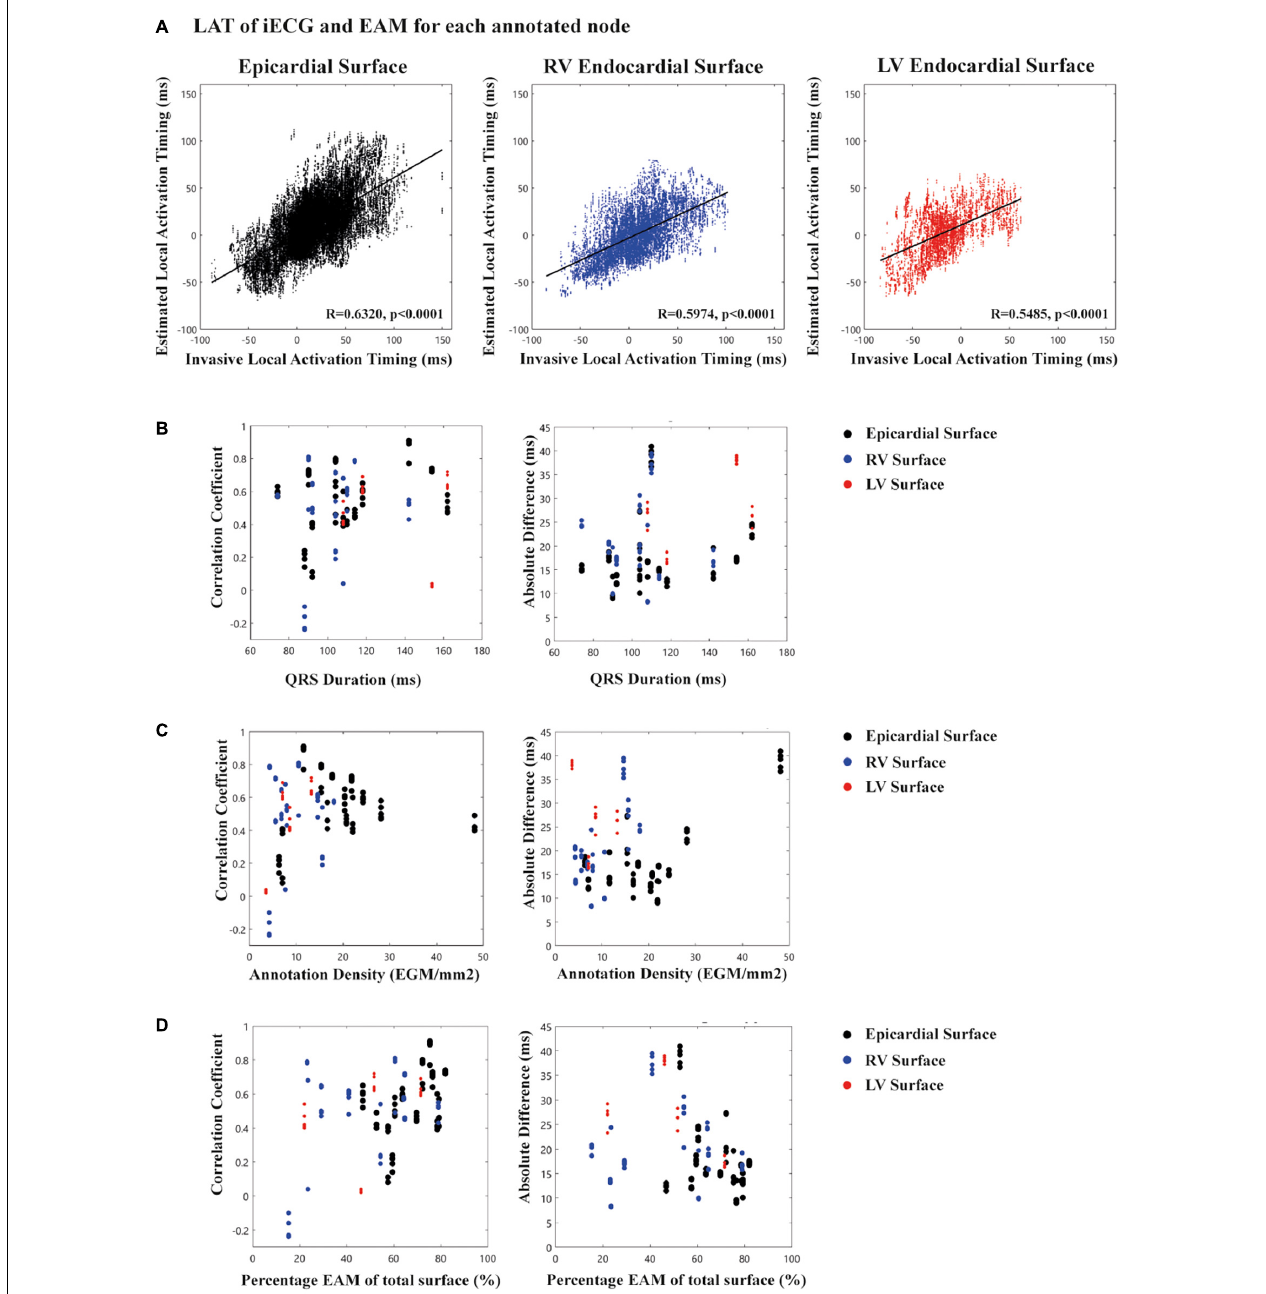
FIGURE 3 | Scatter plots of local activation timing stratified for epicardial and endocardial surfaces. (A) For each node in the ventricular anatomy the EAM-LAT values ( X -axis) are scattered against i ECG-LAT values ( Y -axis). The black line in each plot represents the linear regression line and R-value and p -value are shown in each plot. (B) Relation between QRS duration ( X -axis) for the 5 selected complexes in the i ECG procedure and correlation coefficient/absolute difference for the LAT values ( Y -axis). (C) Relation between annotation density ( X -axis) per mm 2 and correlation coefficient/absolute difference for LAT values for the 5 selected complexes in the i ECG procedure ( Y -axis). (D) Relation between percentage of EAM of the total surface ( X -axis) and correlation coefficient/absolute difference for LAT values ( Y